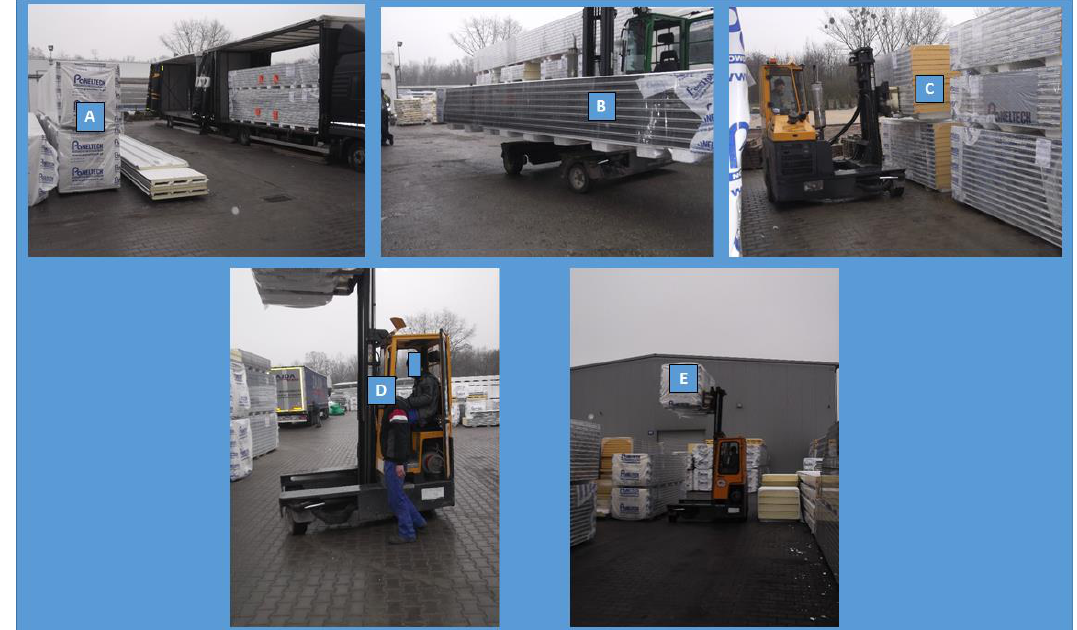
Figure 17. Transporting the load with a forklift. A - pallets in the square; B - the pallet is transported with a forklift; C - the pallet is picked up by a forklift; D - view: forklift forks under the pallet; E - the forklift puts down the pallet.